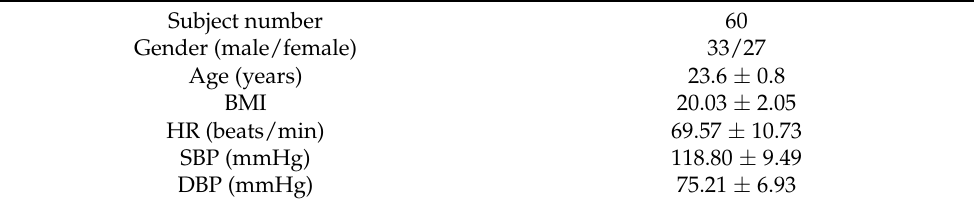
Table 1. Characteristics of the